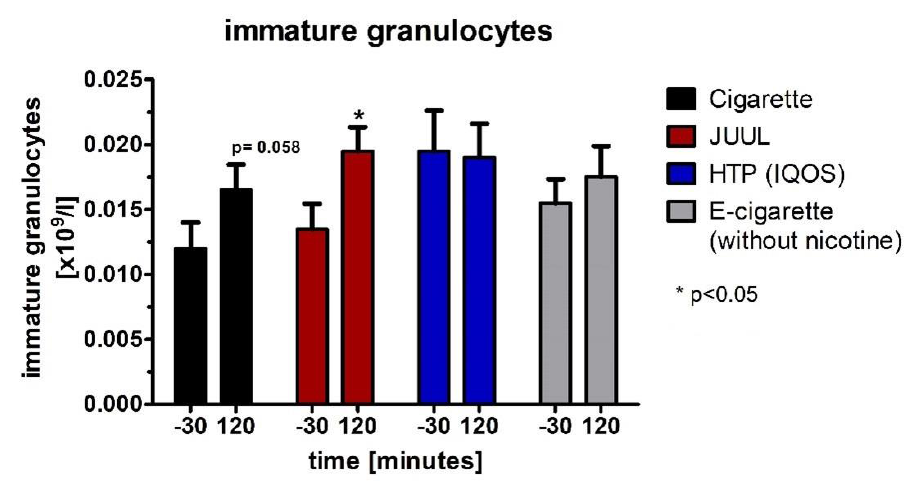
Figure 12. Immature granulocytes analyzed before as well as 120 min after consuming the cigarette, JUUL TM , heated tobacco product, and e-cigarette without nicotine.